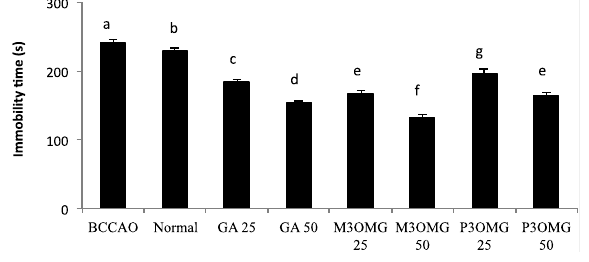
Figure 4. Effects of intraperitoneal administration of GA, M3OMG and P3OMG on swimming time in the despair swimming test. Data are a mean (s) ± SD ( n = 7); different letters indicate statistically significant differences ( p < 0.01) between the two groups.